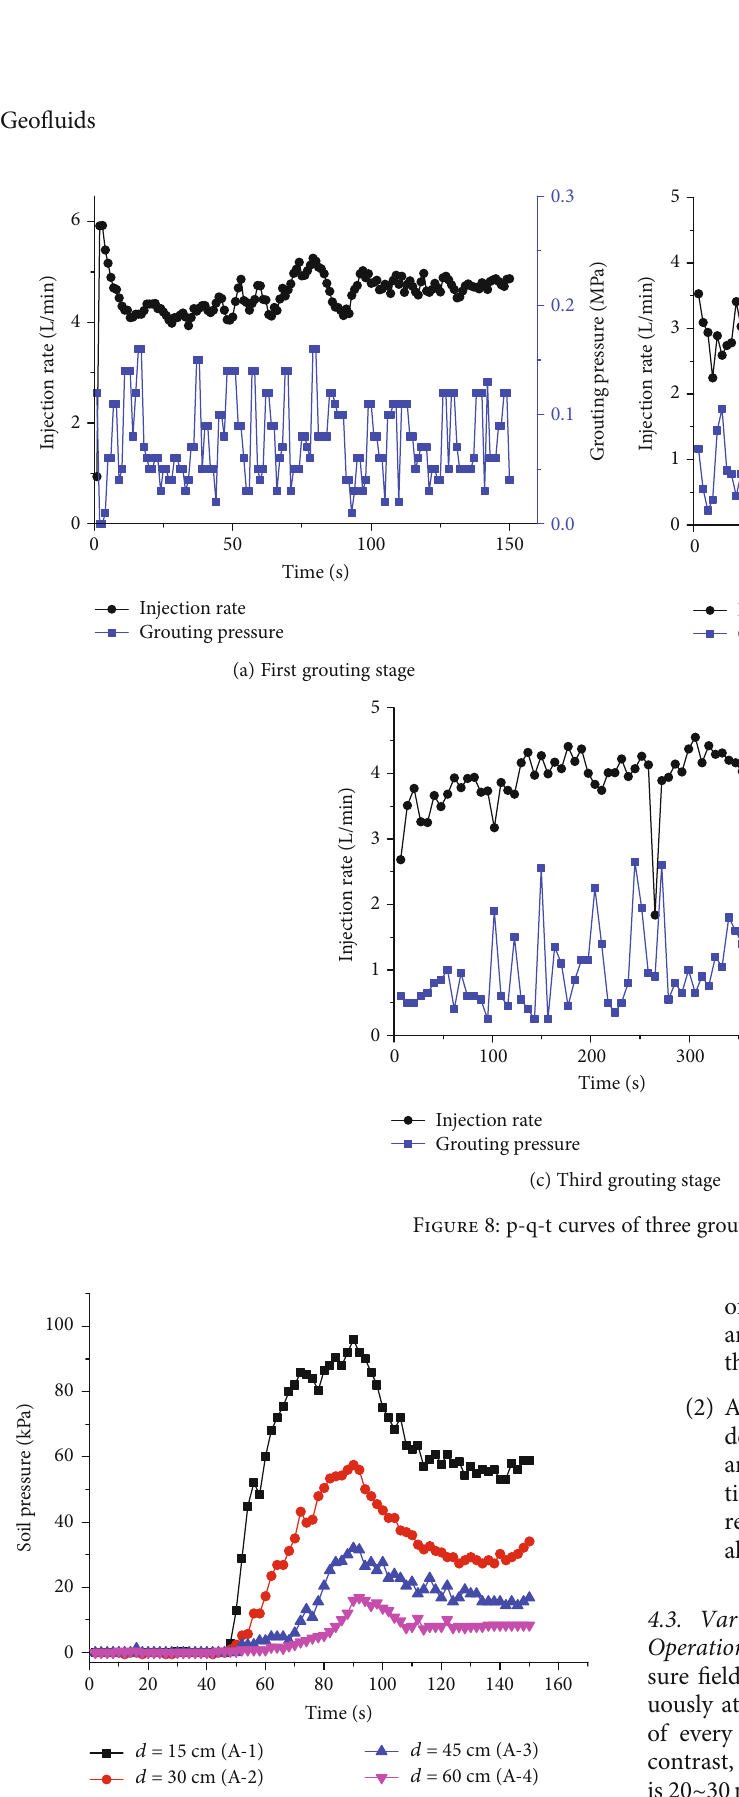
Figure 9: Variation of soil pressure with time of di ff erent